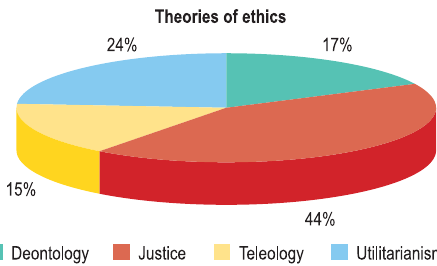
Fig. 6. Theories of ethics selected by the